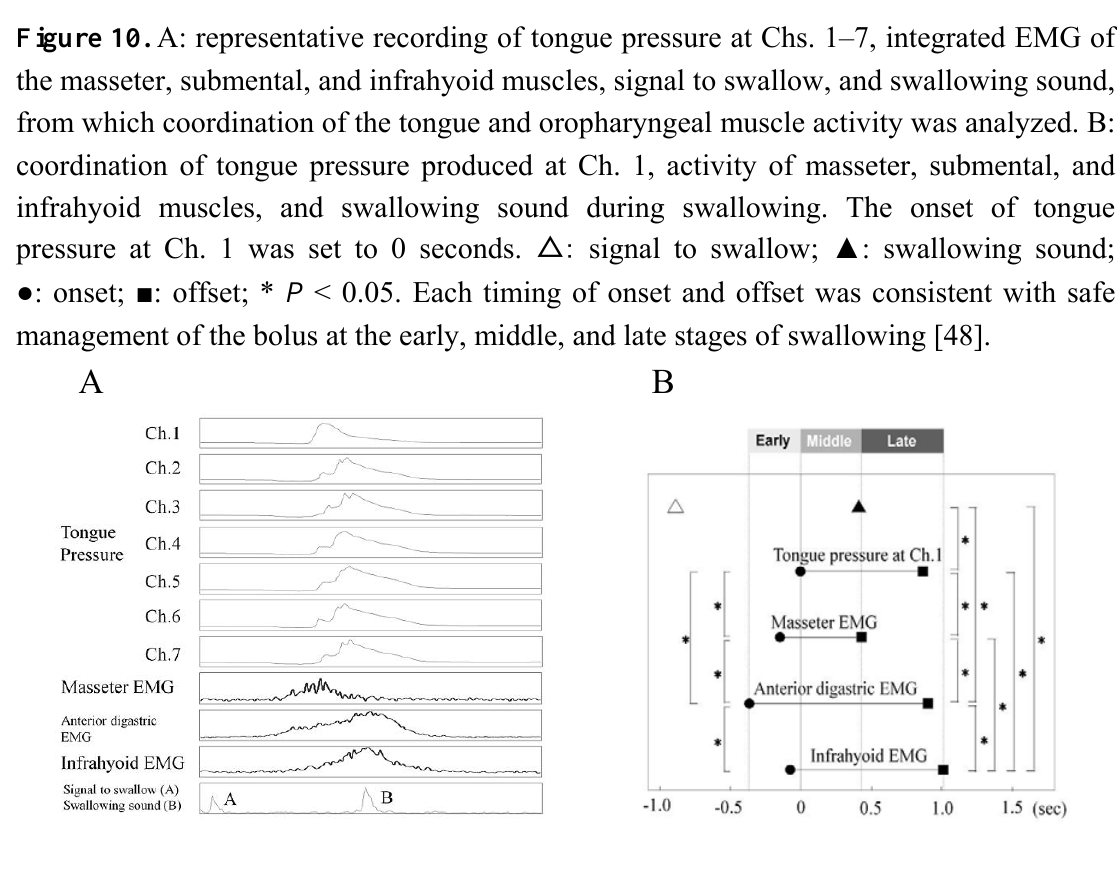
Figure 11. Representative recording of tongue pressure against the hard palate and the vertical trajectory of jaw movement in the masticatory cycle (left box), and coordination between tongue pressure and jaw movement (right box). Significant difference in sequential order is observed regarding the onset and offset of tongue pressure